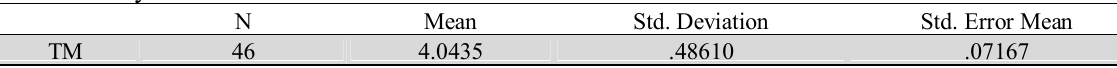
The summary of some basic statistics